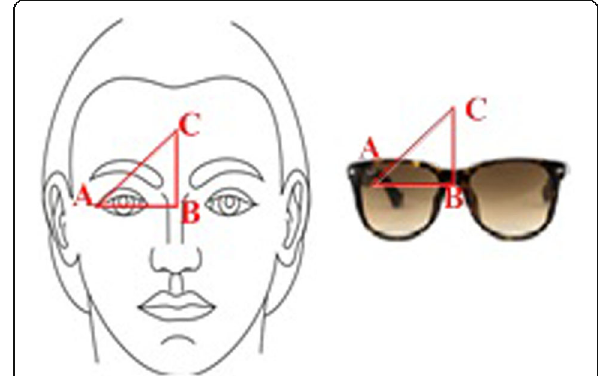
Fig. 19 The isosceles triangle made on face and eyeglass images